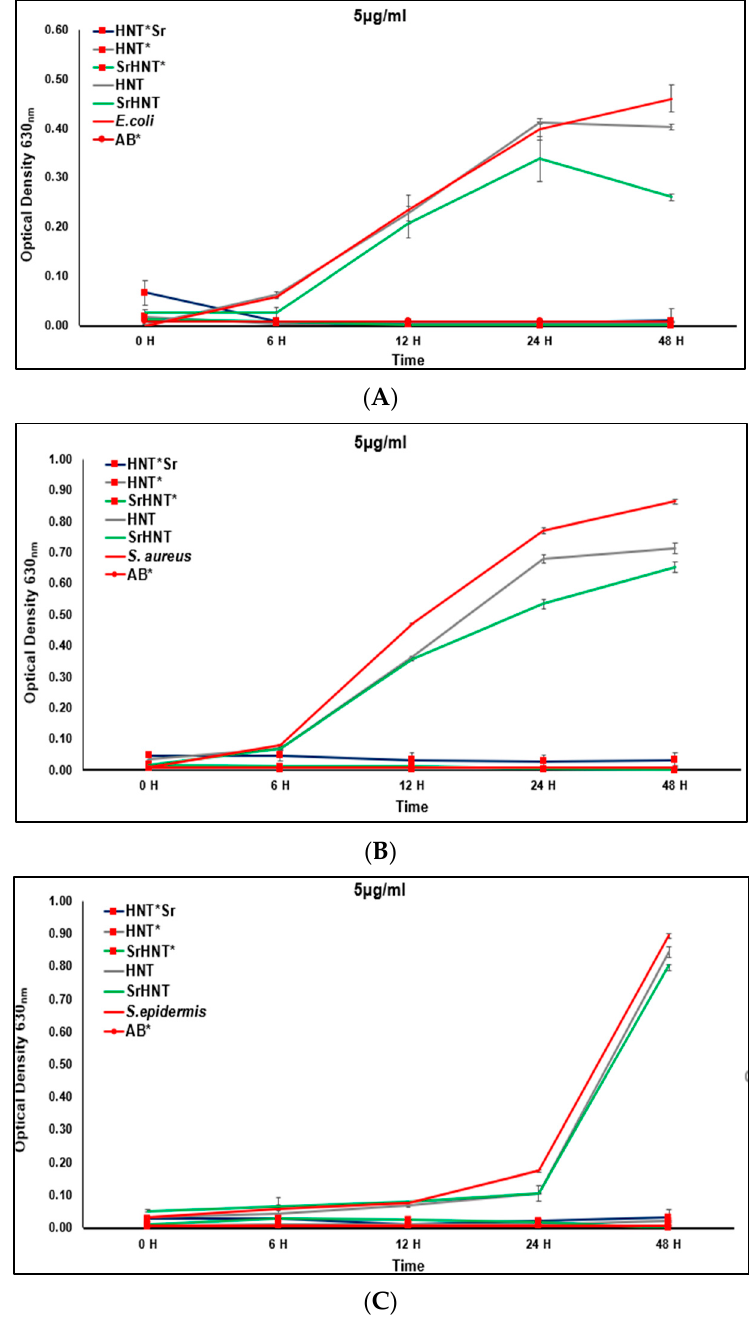
Figure 9. The pattern of bacterial growth over 24 h. Bacterial growth was tested based on the CSLI microtitration method. ( A ) E. coli ( B ) S. aureus ( C ) S. epidermis . The data are the averages of 3 different colonies. In this graph, the concentration of a sample of HNT, SrHNT, and Gentamicin loaded (5 μ g) = HNTs *, SrHNTs *, and HNTSr *. The total reaction mixture was 100 μ L. Error bars indicate the standard error of the mean.